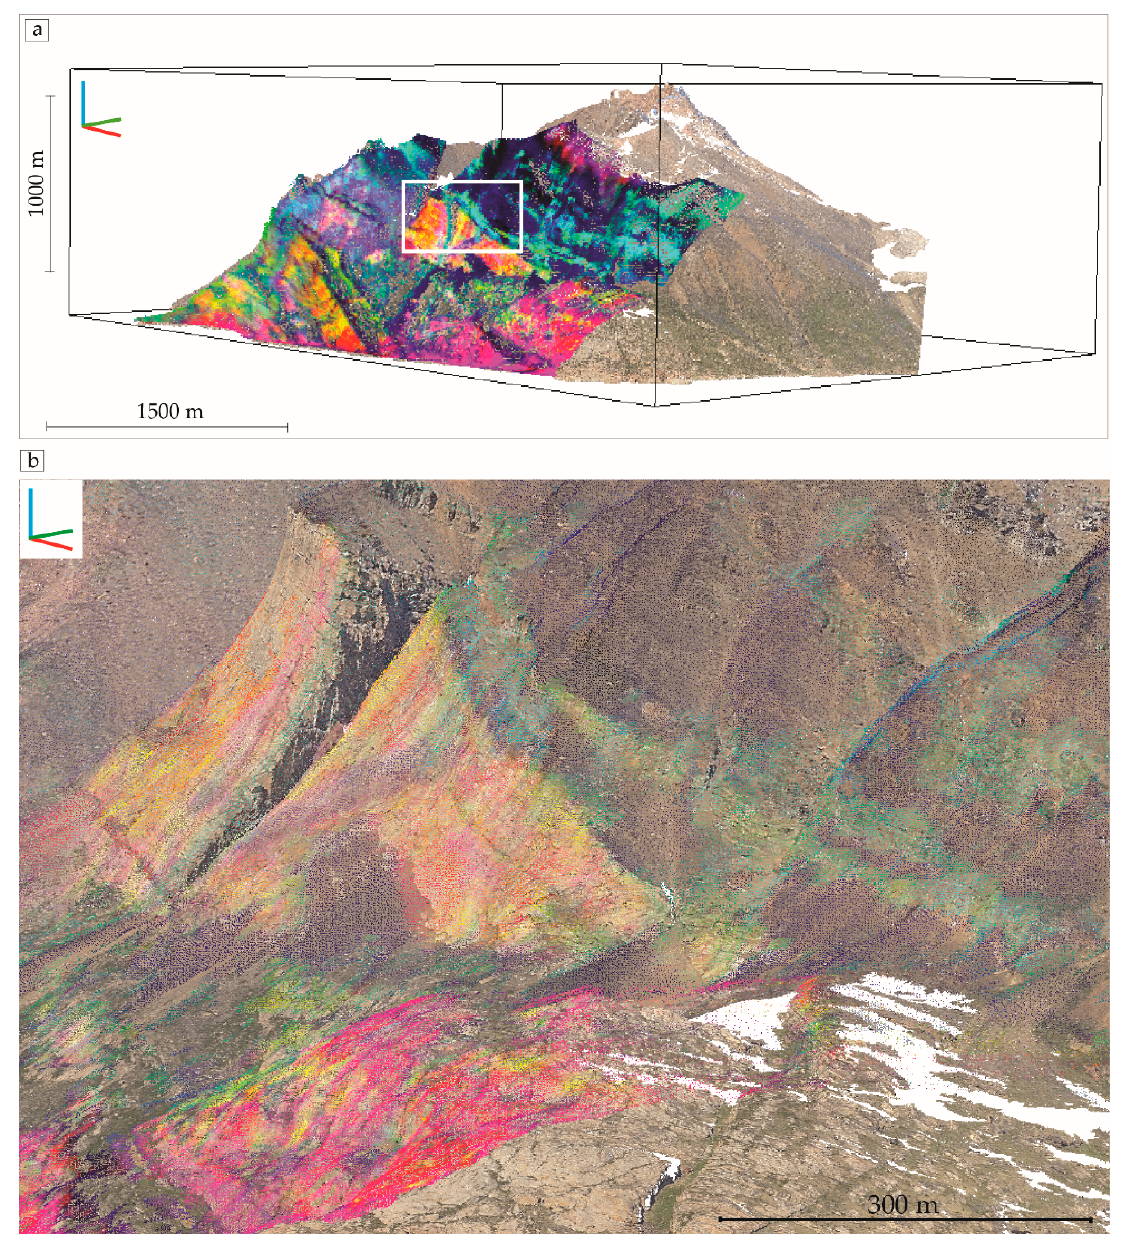
Figure 11. ( a ) 3D point cloud of the Karrat region textured with MNF image; Eigenvectors 2, 7 and 5 of MNF Transform Data are visualized in RGB. x, y and z axes are indicated by red, green and blue colors, respectively. ( b ) A zoomed area (indicated by white frame in ( a )) is used to visualize the accuracy of matching between the two datasets.